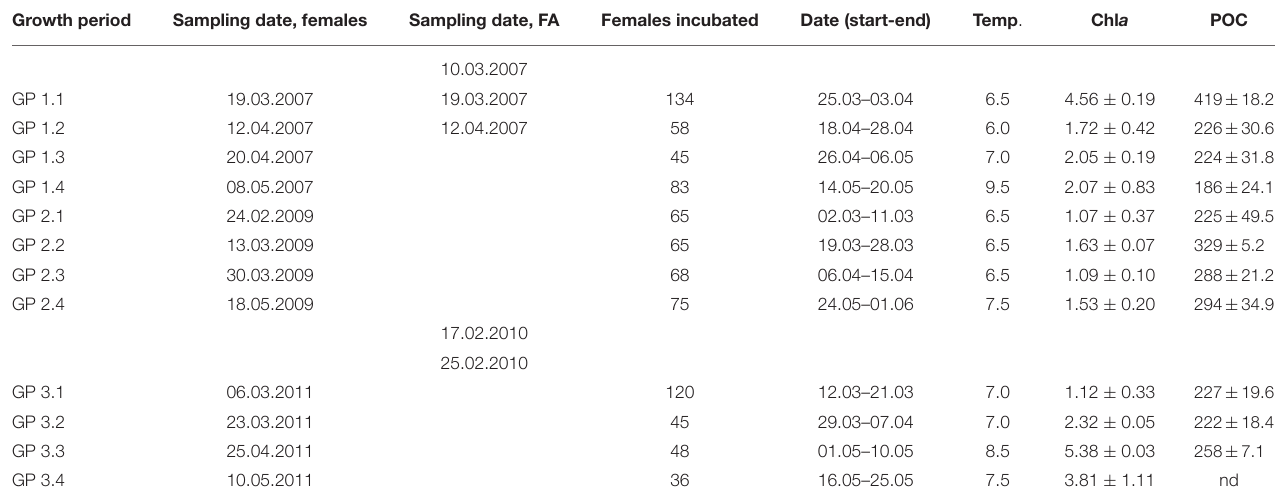
TABLE 2 | Sampling dates for females and fatty acids (FA), number of females incubated, dates for growth experiments, incubation temperatures ( ◦ C) and concentration of Chl a ( µ g L − 1 ), and particulate organic carbon (POC, µ g C L − 1 ). Growth